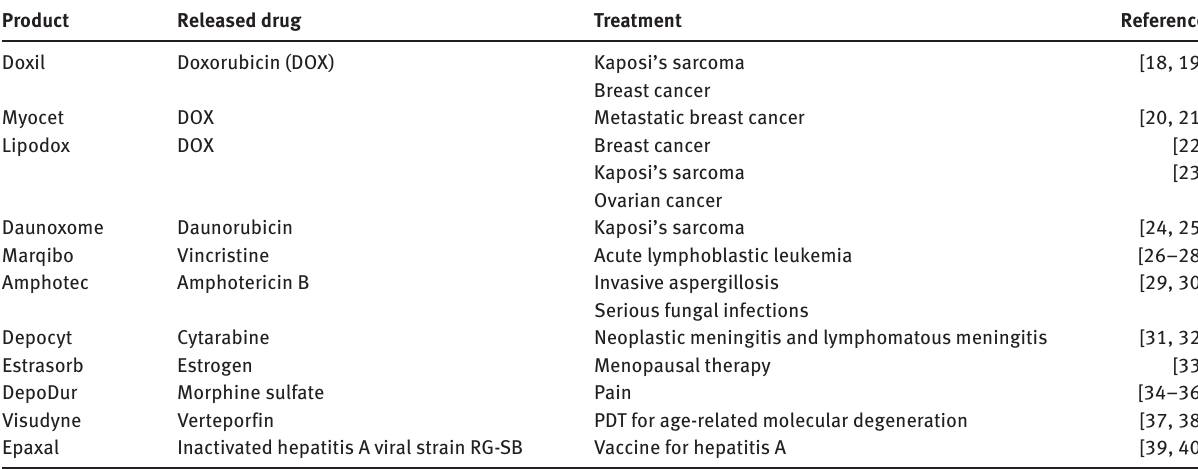
Table 1: FDA-approved liposomal drug delivery systems used in clinical application.